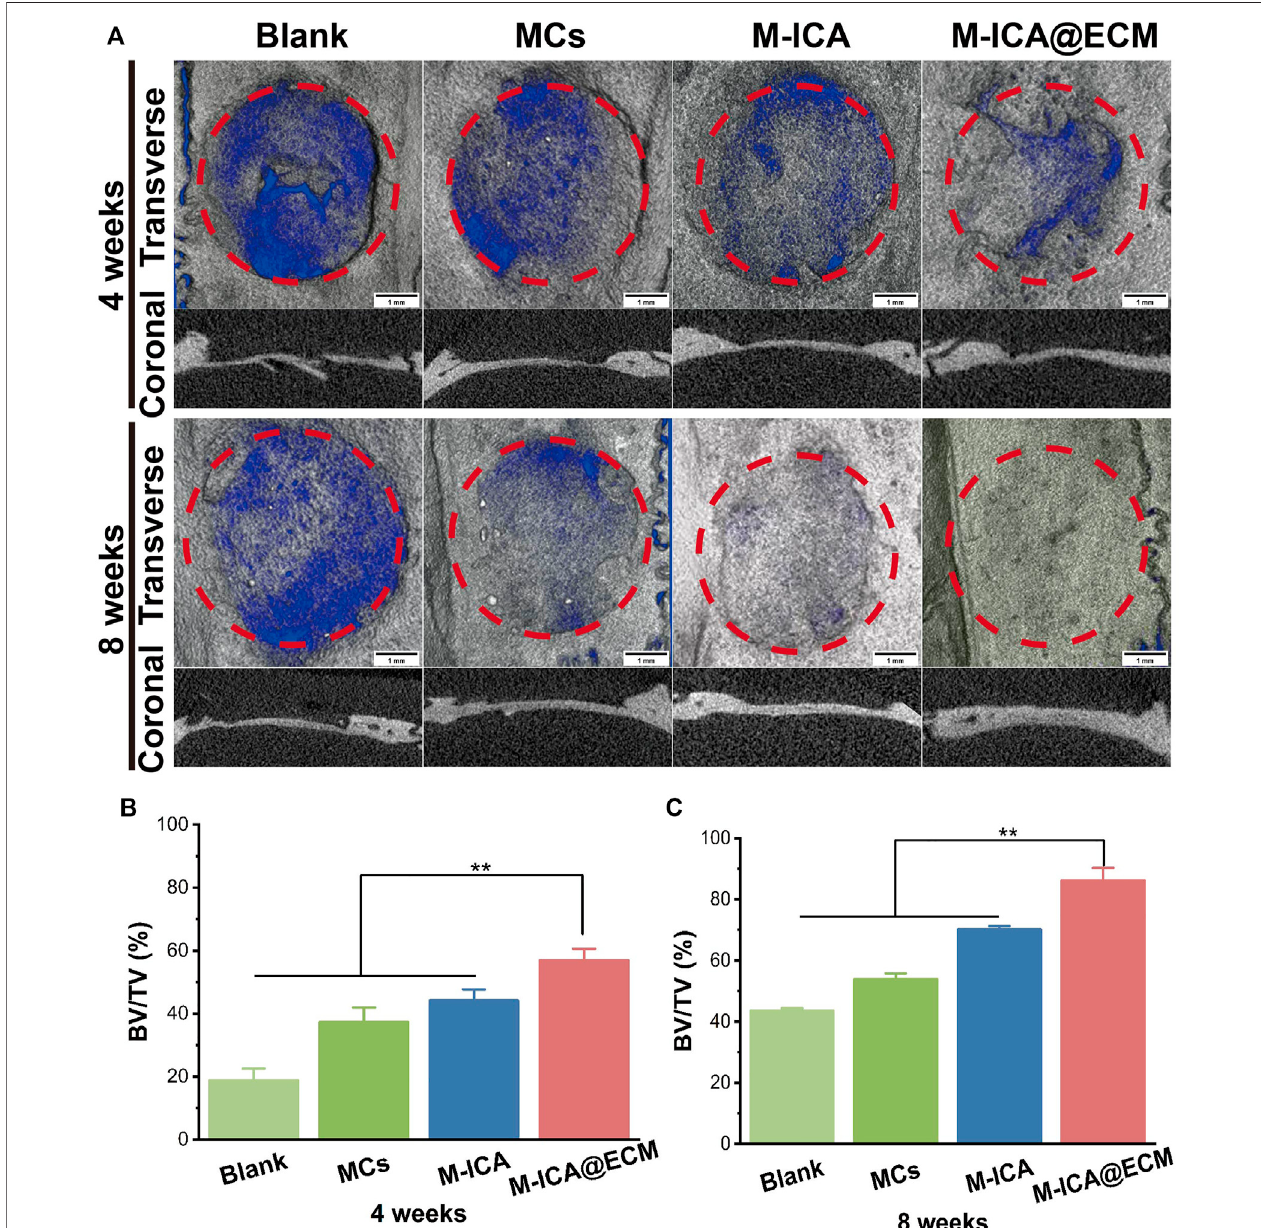
FIGURE9| Theratcalvarialbonerepairafter4and8 weeksofimplantation: (A) Micro-CTimagesoftheratcalvarialbone(Scalebar=1 mm) (B,C) TheratioofBV/ TV at 4 and 8 weeks after implantation (* p < 0.05, ** p < 0.01, n = 3).